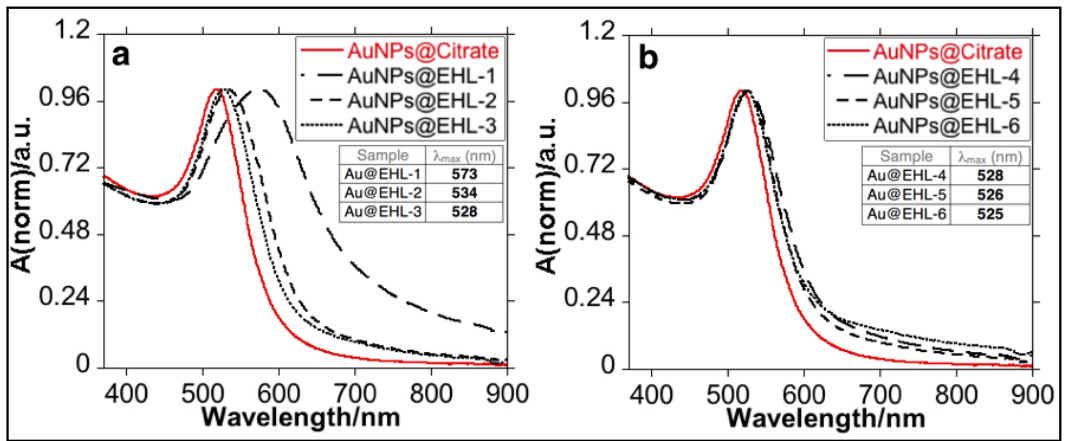
Figure 2. UV-Vis spectra of the different AuNPs@EHL samples synthesized: ( a ) AuNPs@EHL-1, AuNPs@EHL-2, and AuNPs@EHL-3; and ( b ) AuNPs@EHL-4, AuNPs@EHL-5, and AuNPs@EHL-6.